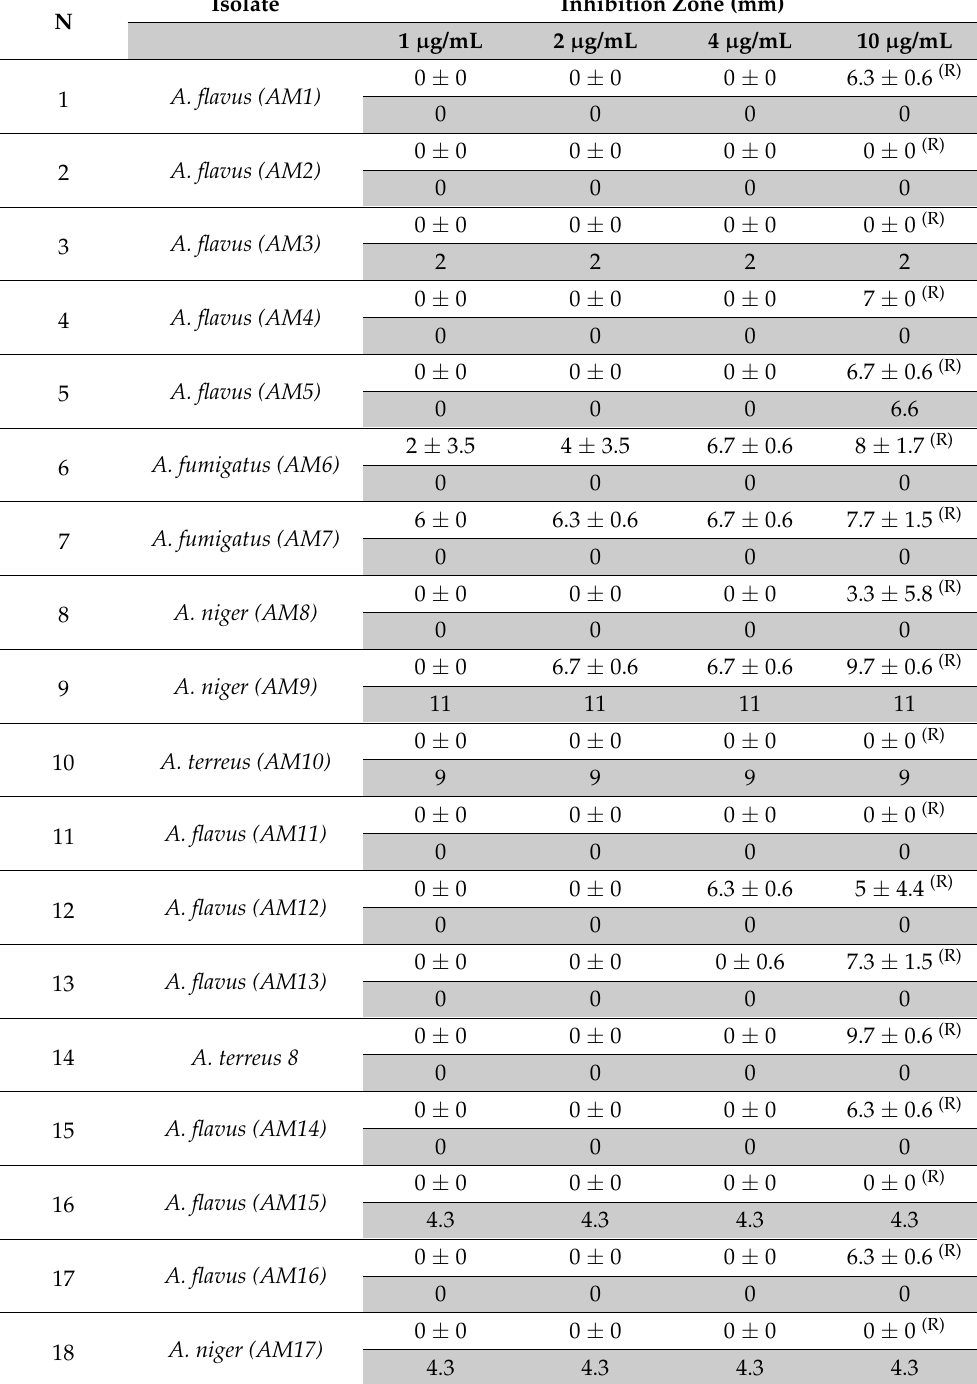
Table 4. Susceptibility of fungal species to different concentrations of